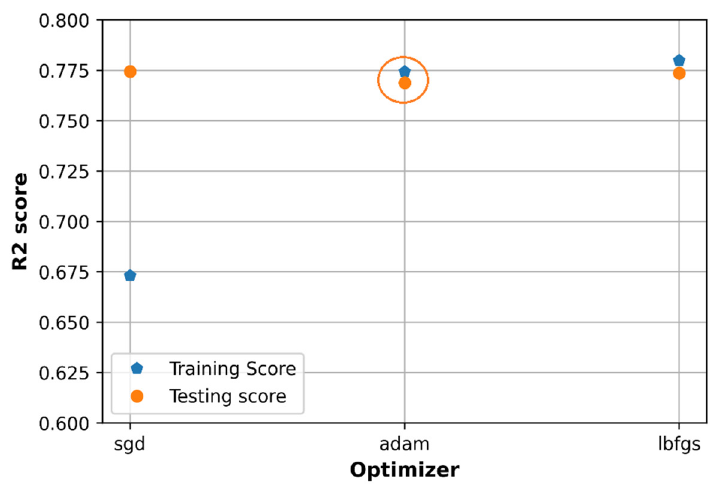
Figure 15. Comparison of loss with different optimizers.